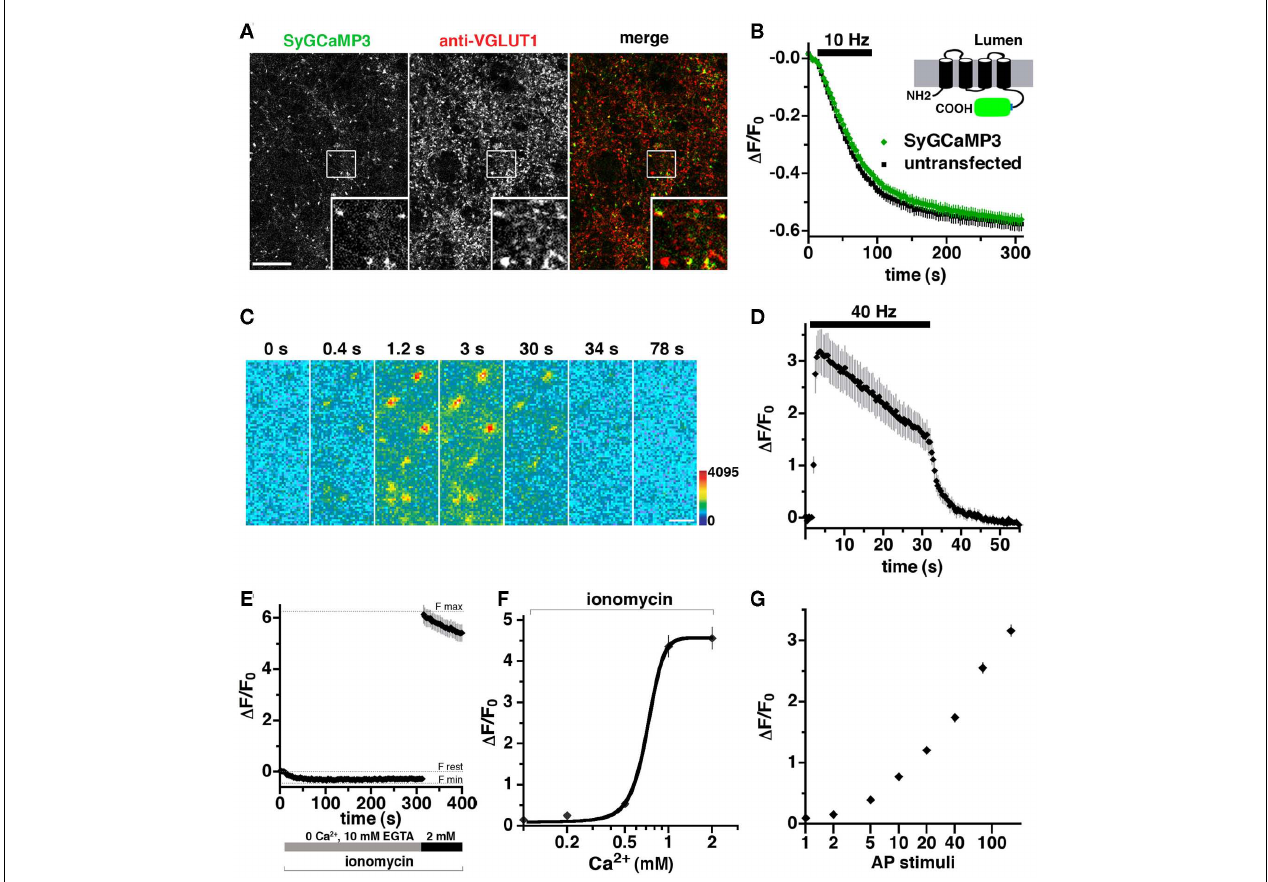
stimulation at 40Hz for 30s. Images are collected every 400ms. (E) The minimum synaptic fluorescence of SyGCaMP3 ( F min ) in transfected hippocampal neurons was determined by perfusion of modifiedTyrode’s solution containing the calcium ionophore ionomycin (5 μ m), 0 Ca 2 + , and 10mM EGTA, resulting in a decrease of Δ F / F 0 =− 0.35 ± 0.03 relative to the resting condition (modifiedTyrode’s containing 2mM CaCl 2 without ionomycin, F rest ).The maximum fluorescence change ( F max ) in the presence of ionomycin and 2mM CaCl 2 is Δ F / F 0 = 6.15 ± 0.35. (F) Semi-logarithmic plot of fluorescence responses to increasing CaCl 2 concentration. (G) Semi-logarithmic plot of integrated fluorescence responses to trains of 1, 2, 5, 10, 20, 40, 80, and 160 action potential (AP) stimuli at 80Hz. Data in (B, D, E, F, and G) are mean Δ F / F 0 ± SEM from at least 30 boutons per coverslip from 7 to 12 coverslips and at least two independent